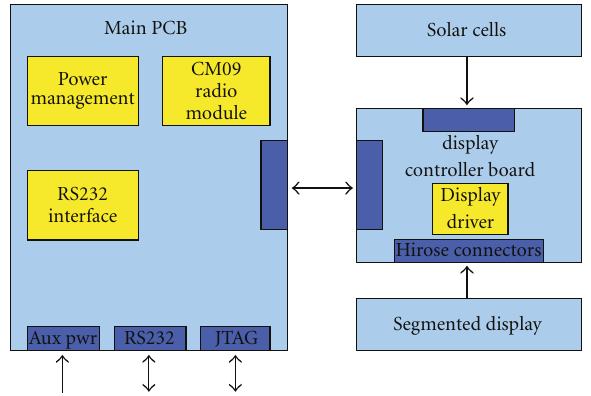
Figure 1: Block diagram of an energy harvesting electronic shelf label.